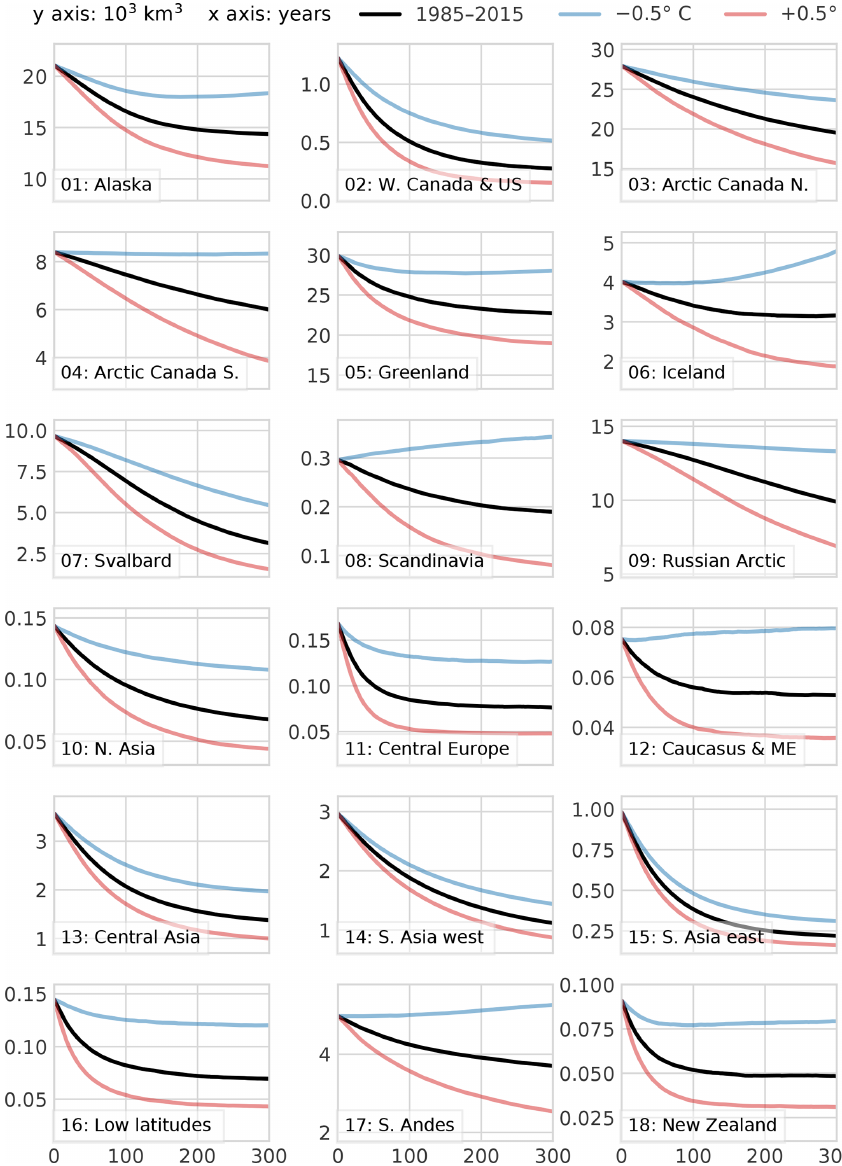
Figure 11. Regional glacier volume change under the 1985–2015 climate (randomized) with three temperature biases ( − 0.5 ◦ , 0 ◦ , and + 0.5 ◦ ). Note the units of the y axes (10 3 km 3 ) and the marked regional